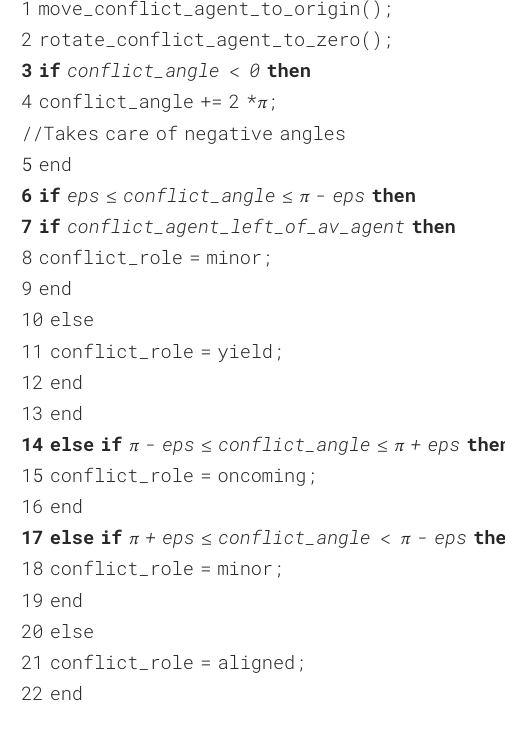
Algorithm 3. Get Agent Role